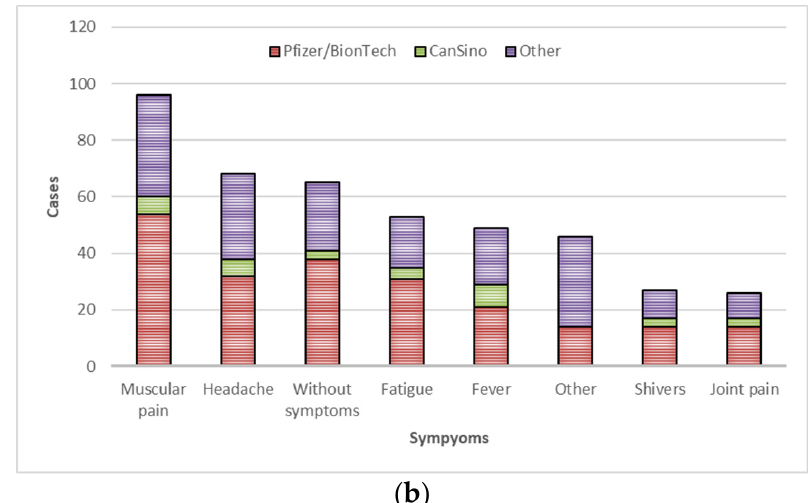
Figure 3. Frequency of side effects. ( a ) First dose. ( b ) Second dose.